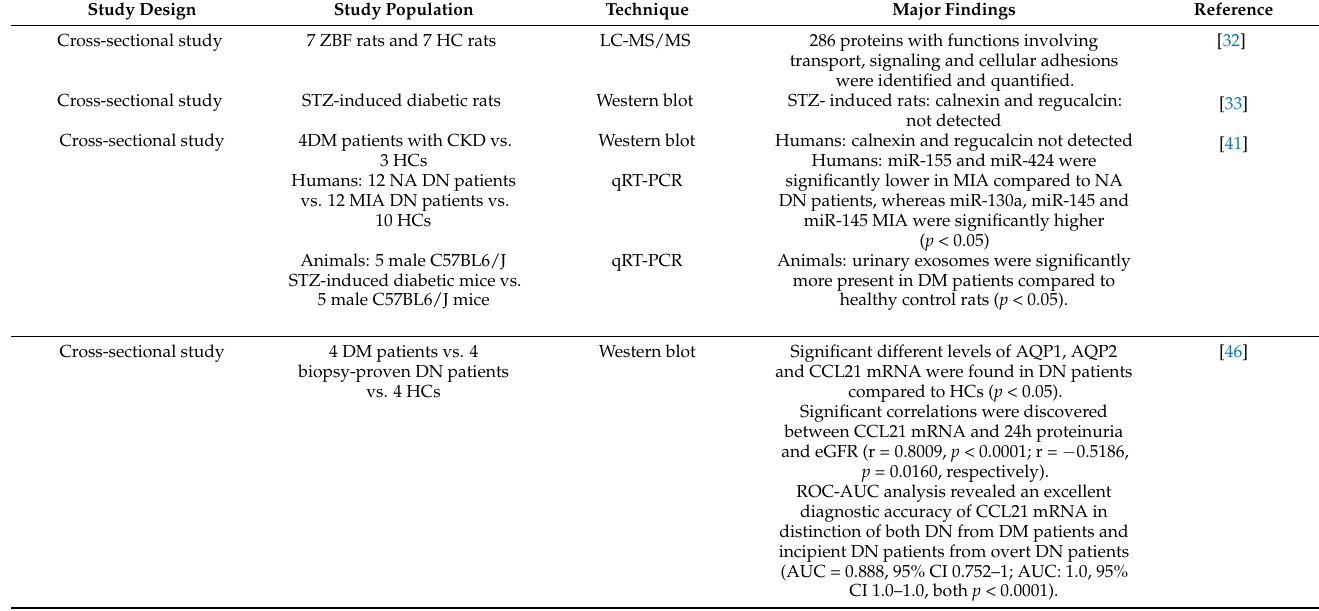
Table 1. Overview of studies of urinary extracellular vesicles in diabetic nephropathy. ZBF: Zucker diabetic fatty rats; HCs: healthy controls; LC–MS/MS: liquid chromatography–tandem mass spec- trometry; DM: diabetes mellitus; DN: diabetic nephropathy; AQP1: aquaporin 1; AQP2: aquaporin 2; CCL21: chemokine ligand 21; eGFR: estimated glomerular filtration rate; CI: confidence interval;